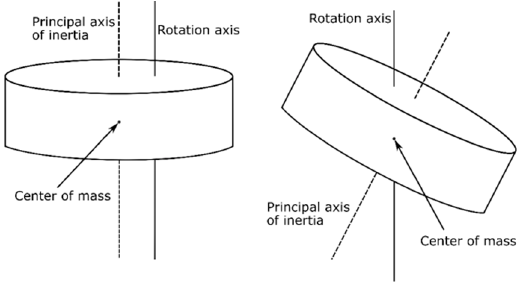
Figure 1. RW imbalances: Static ( left ) and dynamic ( right ).